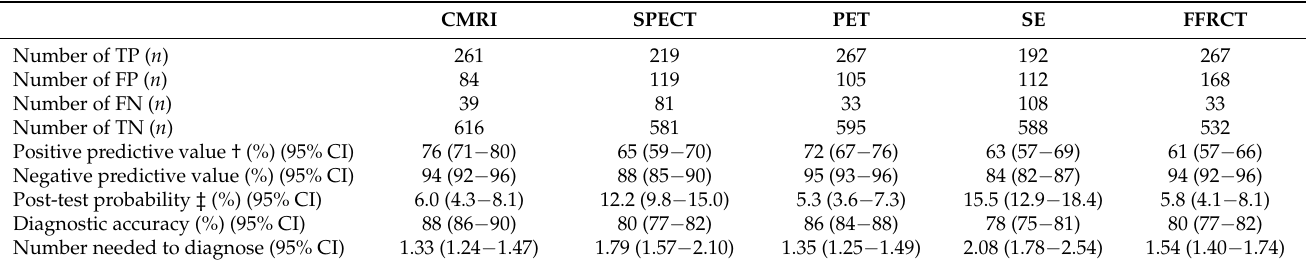
Table 3. A summary of efficiencies at the basic settings (Pre-test probability = 30%).